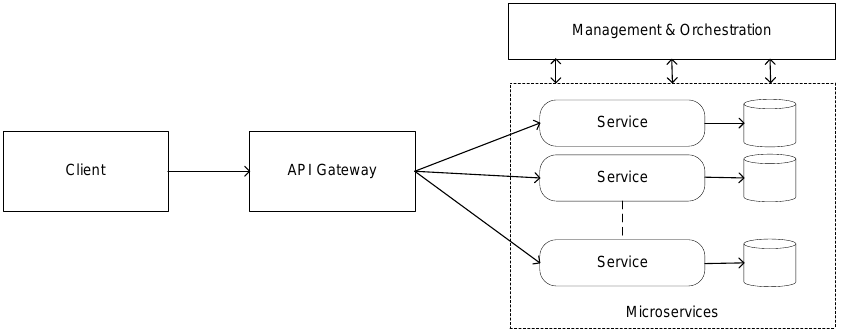
Figure 1. Reference model for MSA. Source: adapted from [17].